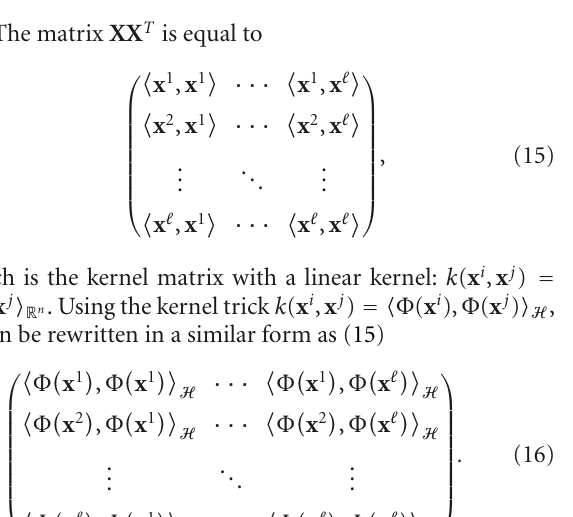
Figure 3: PCA versus KPCA. (a) Three Gaussian clusters, and their projection onto the first two kernel principal components with (b) a Gaussian kernel and (c) a polynomial kernel. (d), (e), and (f) represent, respectively, the contour plot of the projection onto the first component for the PCA, the KPCA with Gaussian kernel, and the KPCA with a polynomial kernel. Note how with the Gaussian kernel the first component “picks out” the individual clusters [20]. The intensity of the contour plot is proportional to the value of the projection, that ( x ) has a high is, light gray indicates that Φ 1 kpc